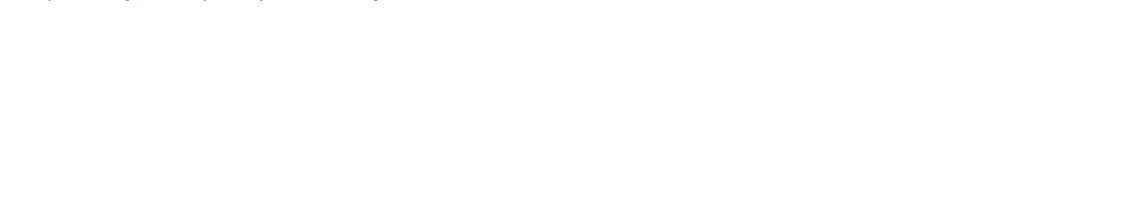
PLOS ONE | https://doi.org/10.1371/journal.pone.0274699 October 19,